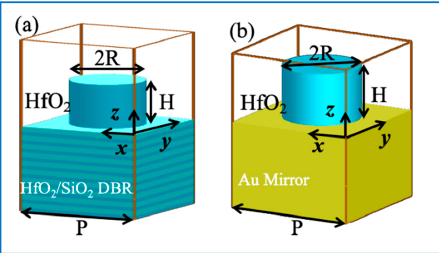
Figure 2. Schematics of the unit cells constituting meta-reflectors: ( a ) 3D view of HfO 2 nanopillars with DBR as a bottom mirror that is made of alternately arranged 159-nm-thick HfO 2 layers and 228-nm-thick SiO 2 layers; ( b ) 3D view of HfO 2 nanopillars with Au film as a bottom mirror. The lattice constant is P = 0.66 µ m.